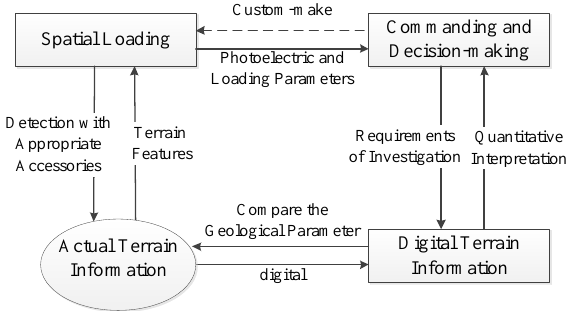
Figure 3. The closed-loop control system of spatial loading and feature information